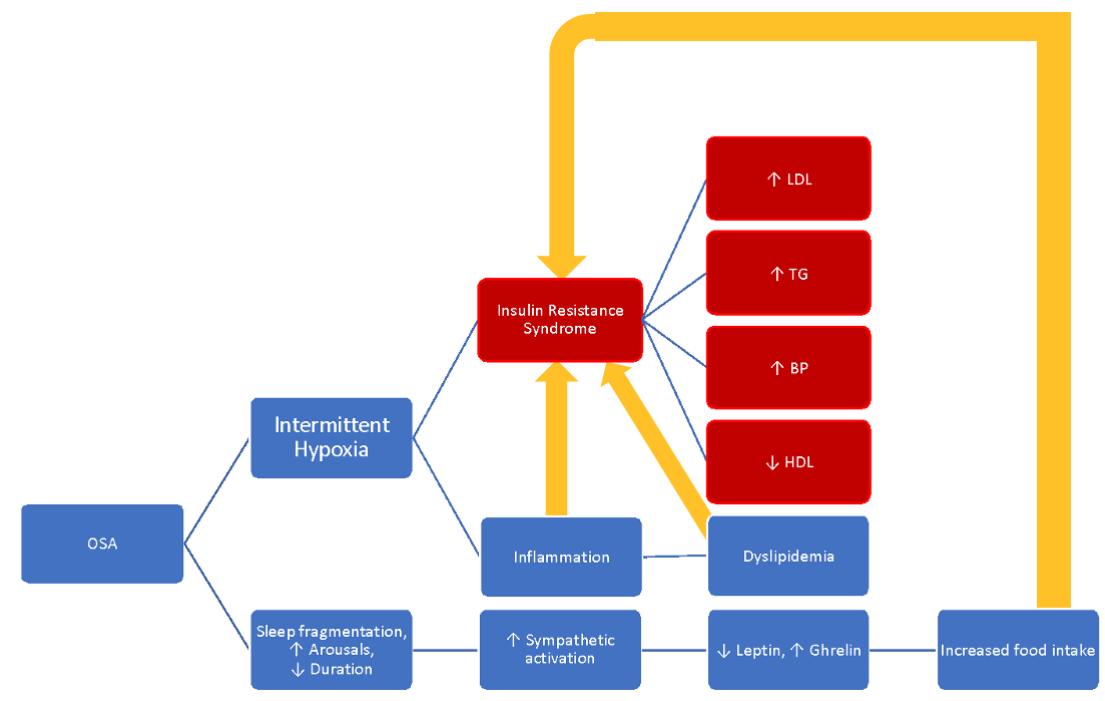
Figure 2. Metabolic alterations of obstructive sleep apnea. LDL = low-density lipoprotein; TG = triglyceride; BP = blood pressure; HDL = high-density lipoprotein.